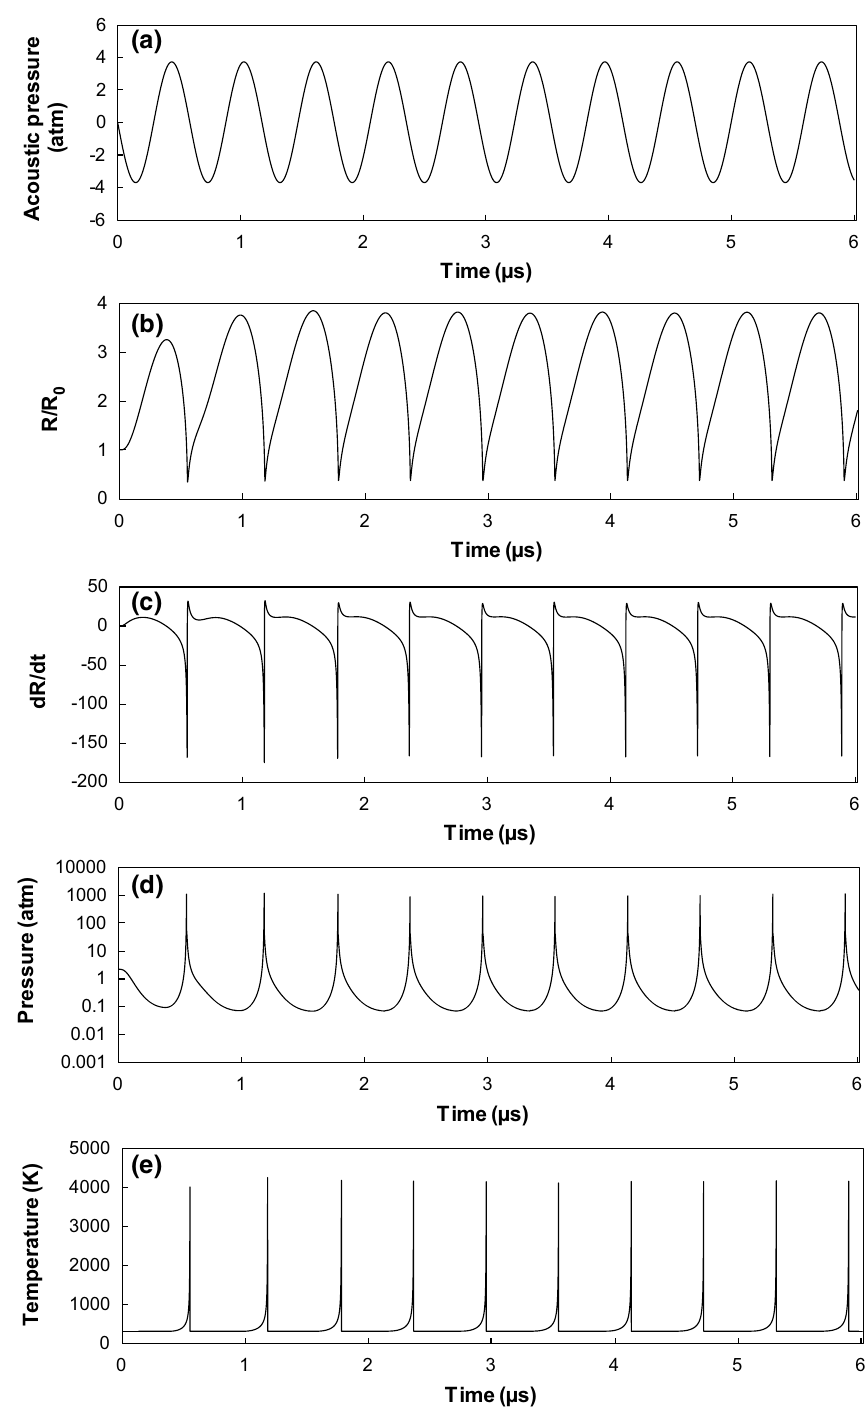
Fig. 1 Predicted acoustic pres- sure ( a ), normalized bubble radius evolution ( b ), bubble wall velocity (d R/ d t ) ( c ) and bubble pressure ( d ) and tem- perature ( e ) responses during the oscillation of an air bubble in water upon a sound wave at 1700 kHz and 15 W (simula- tion conditions: ambient bubble radius: 1.2 µm; bulk liquid tem- perature: 25 °C, static